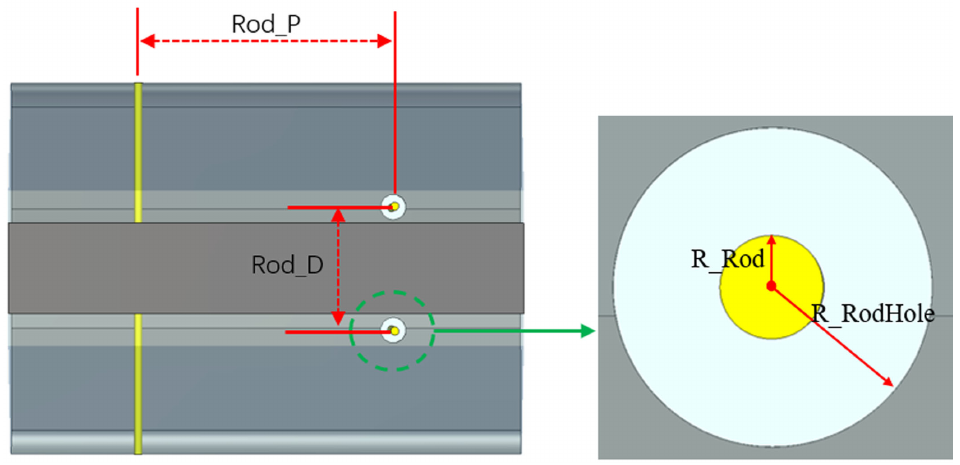
FIG. 8. Geometry of the PISL.